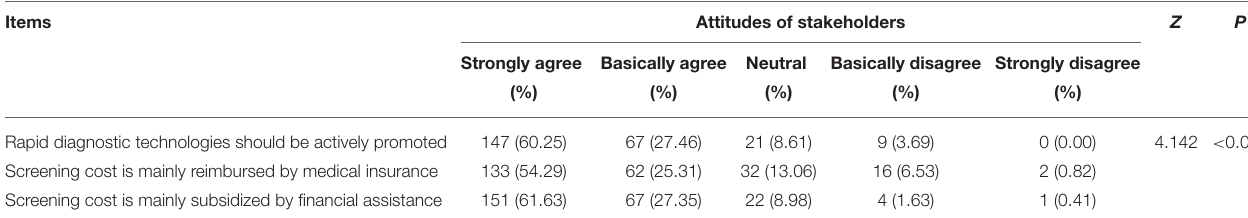
TABLE 6 | Attitudes of stakeholders among service providers toward strategies for the application of RR-TB rapid diagnostic